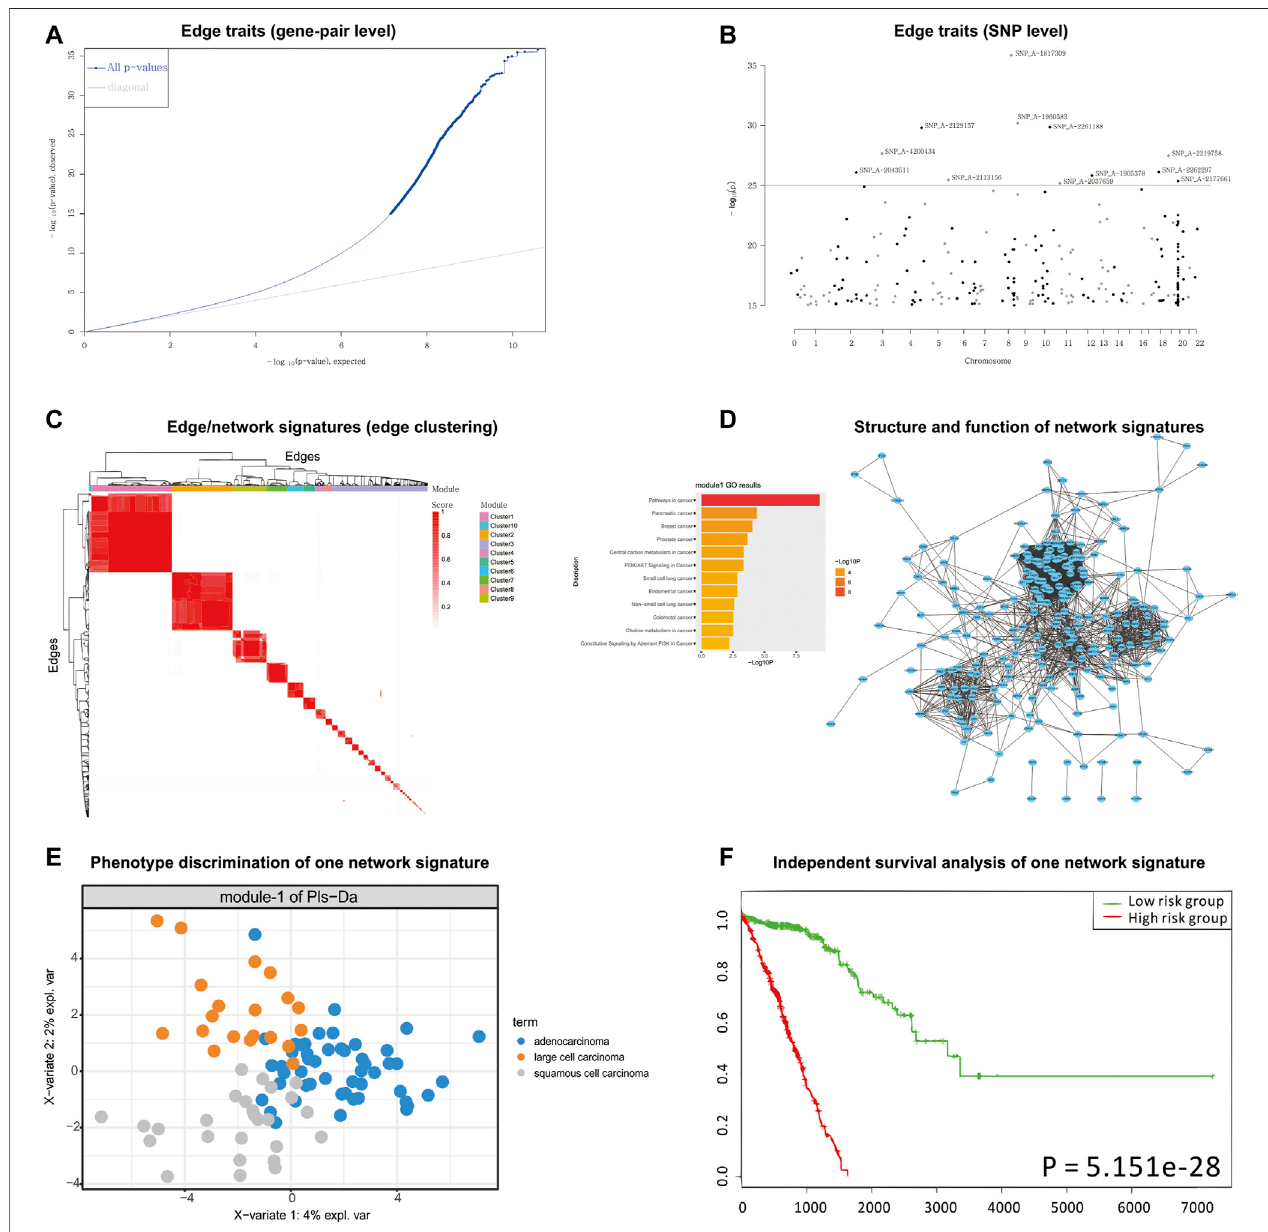
FIGURE 3 | nQTL analysis results from lung cancer dataset. (A) QQ-plot of edge trait on the gene level. (B) Manhattan plot of edge trait on the SNP level. (C) Network signature from edge/gene-pair clustering. (D) The network structure and function of one network signature. (E) PLSDA of one signi fi cant network signature for subtyping a disease. (F) Survival analysis and validation of one signi fi cant network signature.